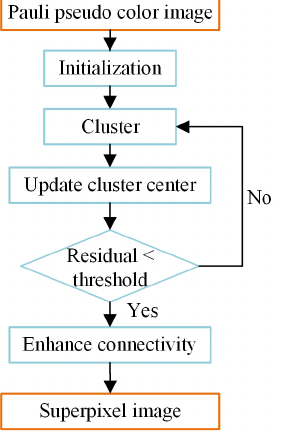
Figure 2. Flowchart of